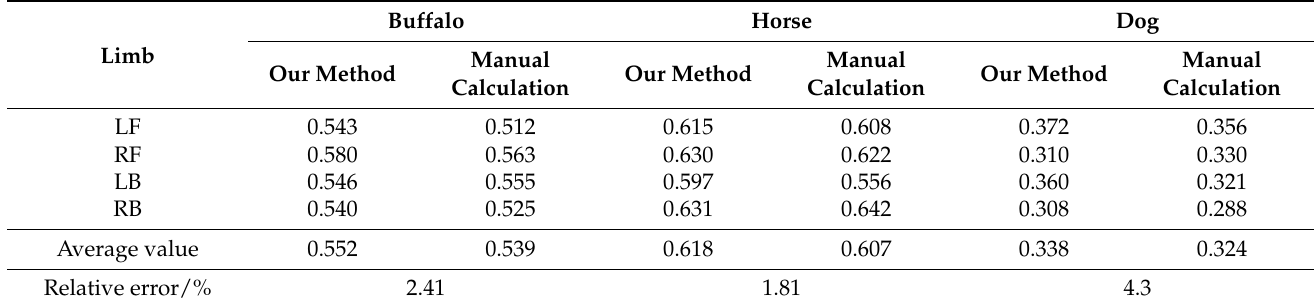
Figure 20. ( a ) Dog’s gait cycle of LF, RF leg; ( b ) dog’s gait cycle of LB, RB leg. We can calculate the gait duty cycle parameters for the buffalo, horse, and dog by using Formula (10) and Figures 18–20, and the results are shown in Table 7. Table 7. Gait duty cycle of buffalo, horse, and dog. Horse